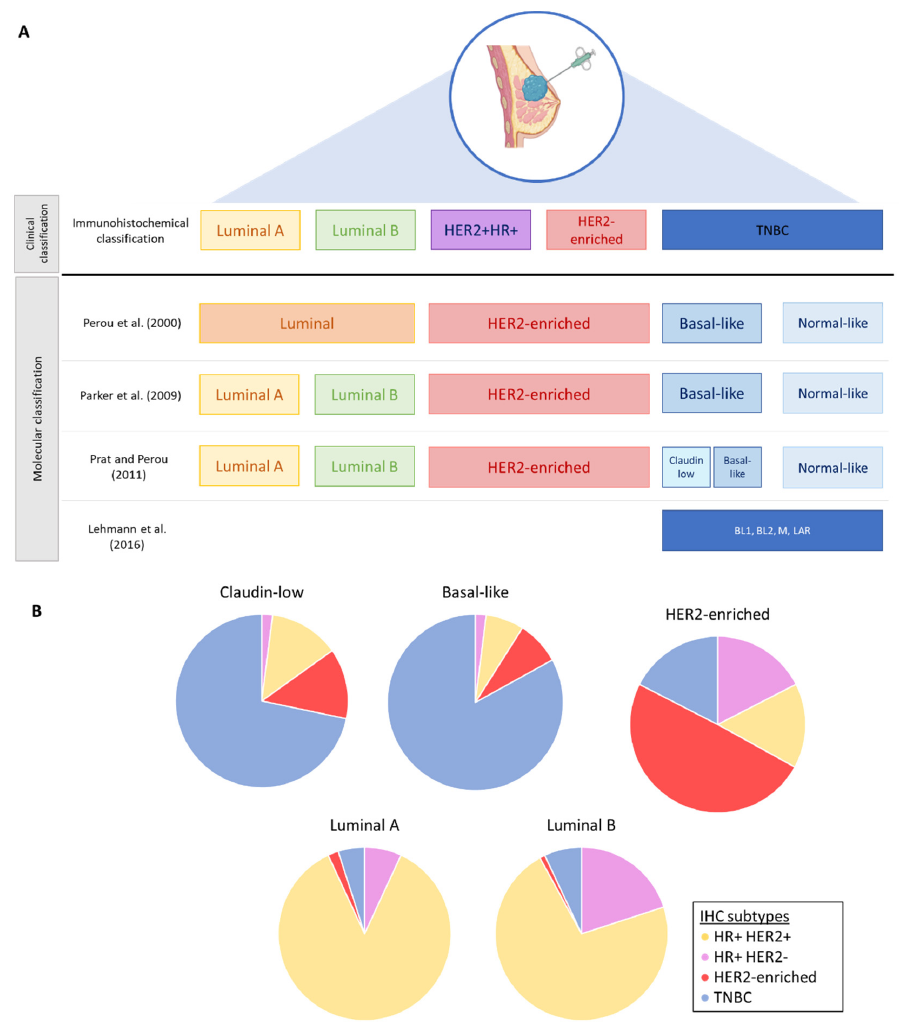
Figure 2. Breast cancer subtypes and intrinsic classification. ( A ) Comparison between immunohisto- chemical classification and molecular classification [17,18,24,25]. ( B ) Distribution of immunohisto- chemical subtypes in the molecular classification, as defined by Prat and Perou [24]. HR+: hormone receptor-positive; TNBC: triple negative breast cancer; BL1: basal-like 1; BL2: basal-like 2; M: mes- enchymal; LAR: luminal androgen receptor . 2.2. Intratumoral Heterogeneity in Breast Cancers Intratumoral heterogeneity (ITH) in breast cancer refers to the diversity found within tumors, existing at several levels [27,28]. ITH includes multiple concepts and principles such as clonal heterogeneity and cell state heterogeneity [14,27,29]. Clonal heterogeneity concerns the phenotypic variability between cells within a tumor depending on spatial and temporal factors, leading to different clones of cells with different sensitivities to treat- ment. Many spatial factors can influence the clones of cells: hypoxia variance from the center of the tumor to the periphery, angiogenesis, pH variation inside the tumor and interactions with cells from the tumor microenvironment (TME). Depending on their ex- posure to hypoxia, or other factors, cells will acquire different metabolisms and different sensitivities to treatment. Temporal factors are more related to the sequential exposure of the tumor to different lines of treatment that could lead to a selection of resistant clones